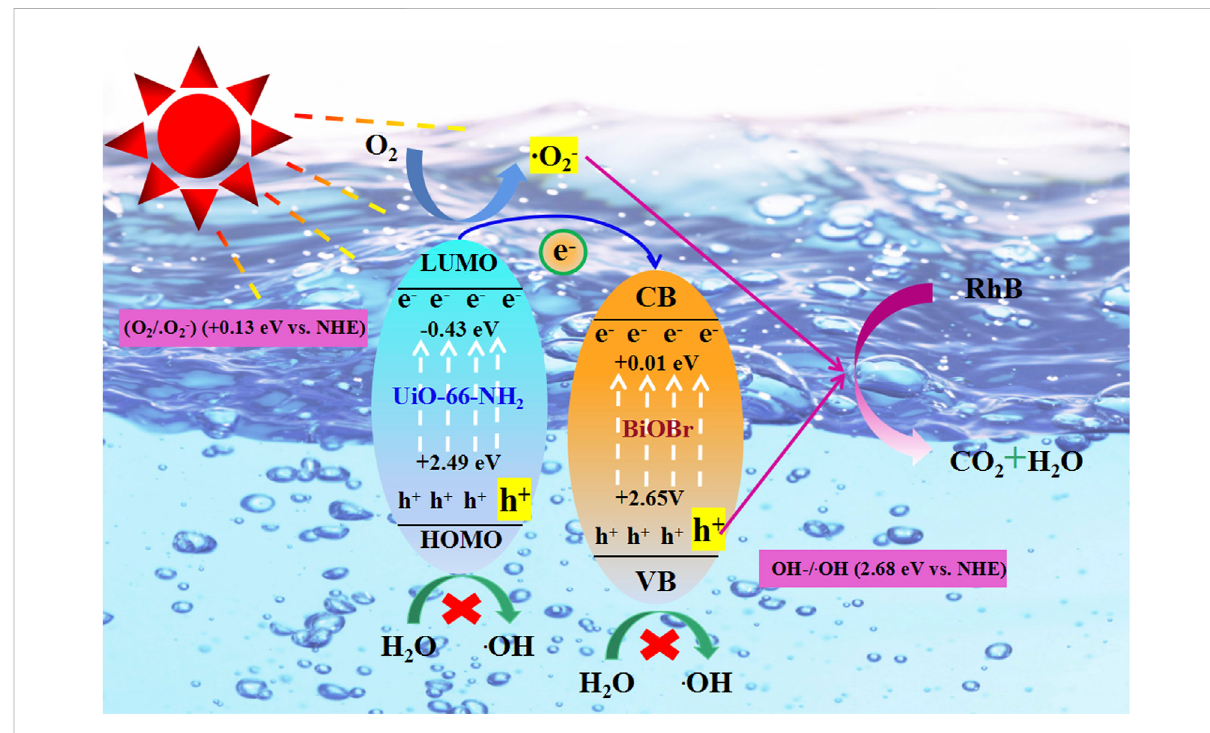
FIGURE 12 The plausible photodegradation mechanism of RhB over UB-30% composite under simulated sunlight